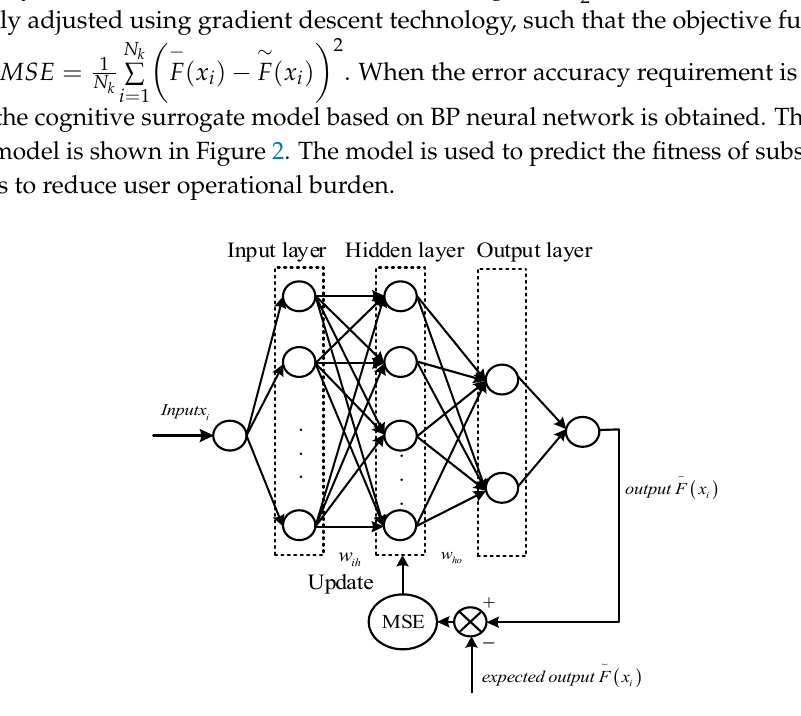
Figure 2. Topology of the surrogate model.